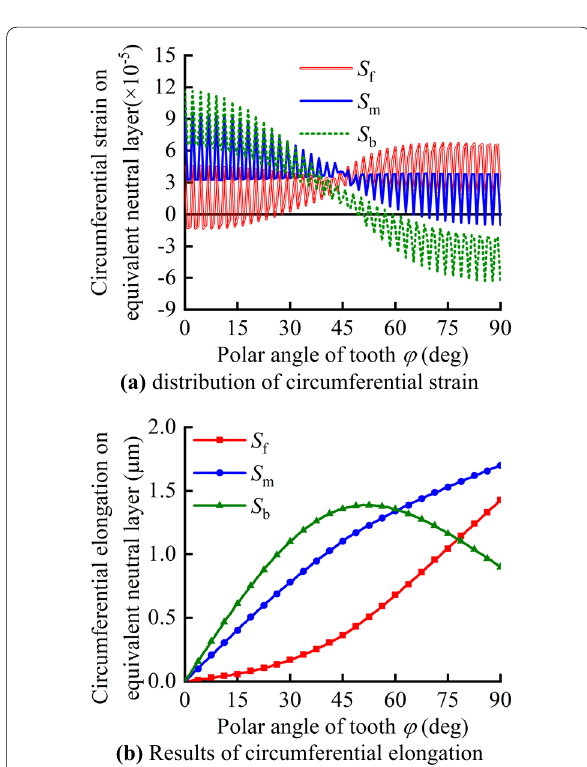
(b) Results of circumferential elongation Figure 20 Circumferential strain and elongation on the equivalent neutral Layer of tooth rim of cup-shaped